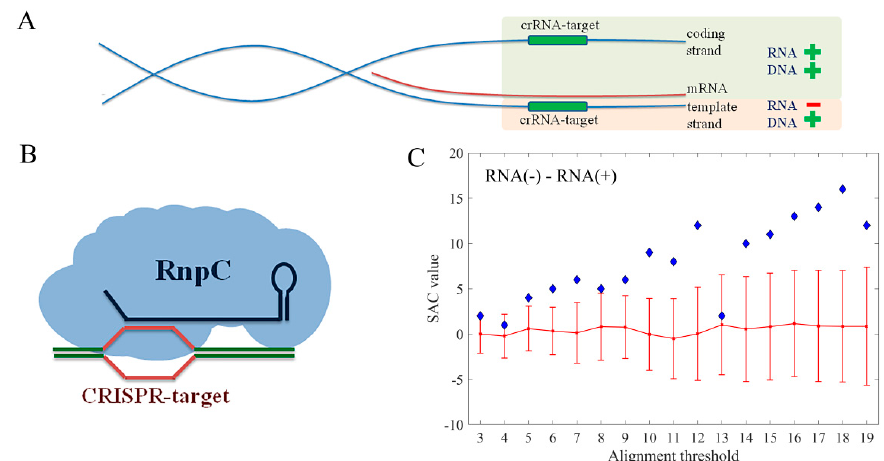
Figure 5. ( A ) Schematic representation of the functional classification of hits associated with coding regions, based on the DNA strand that is being targeted, and ( B ) the interference RnpC; ( C ) The plot showing the difference between SAC values associated with targets classified as RNA − and RNA+